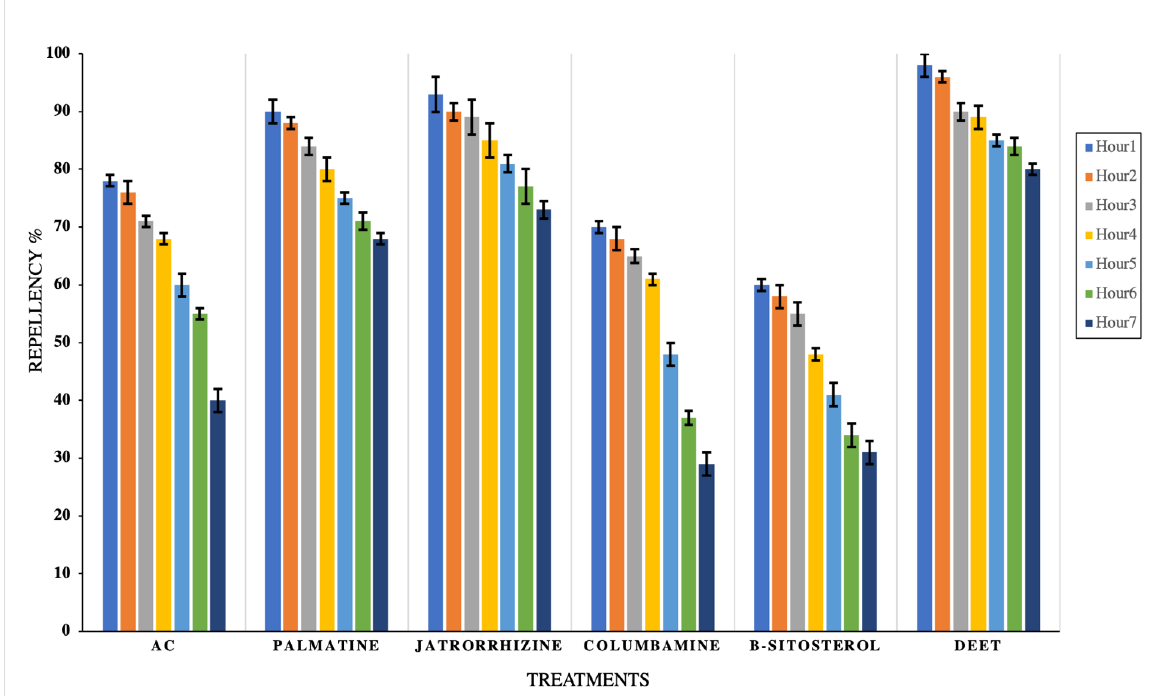
Figure 5. Repellency effect of the LC 50 concentrations of palmatine, jatrorrhizine, columbamine, β - sitosterol, and Annickia chlorantha extract (AC) for seven consecutive hours against the mosquito, Culex pipiens , adult females. Data presented as average % ± SE. Three replicates were used in each treatment. The negative control group recorded zero repellency action.